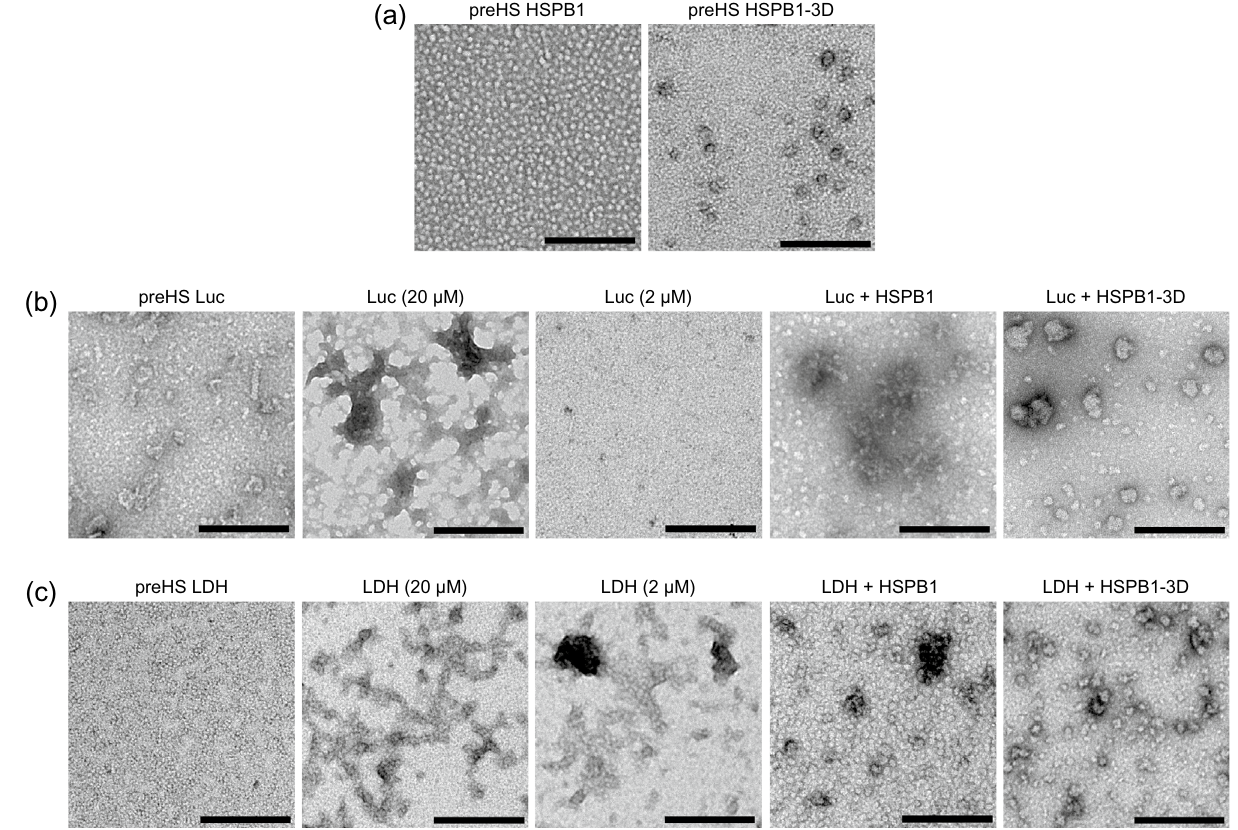
Figure 2. HSPB1-3D regulates the size and morphology of aggregates. ( a – c ) Representative negative stained electron micrographs of ( a ) native HSPB1 and HSPB1-3D; and of ( b ) luciferase or ( c ) LDH before and after incubation for 15 min at 45 °C or 55 °C, respectively. The aggregates in the presence of 20 µM HSPB1 or HSPB1-3D were prepared with 2 µM luciferase or LDH. Luciferase alone could not be detected at 2 µM,